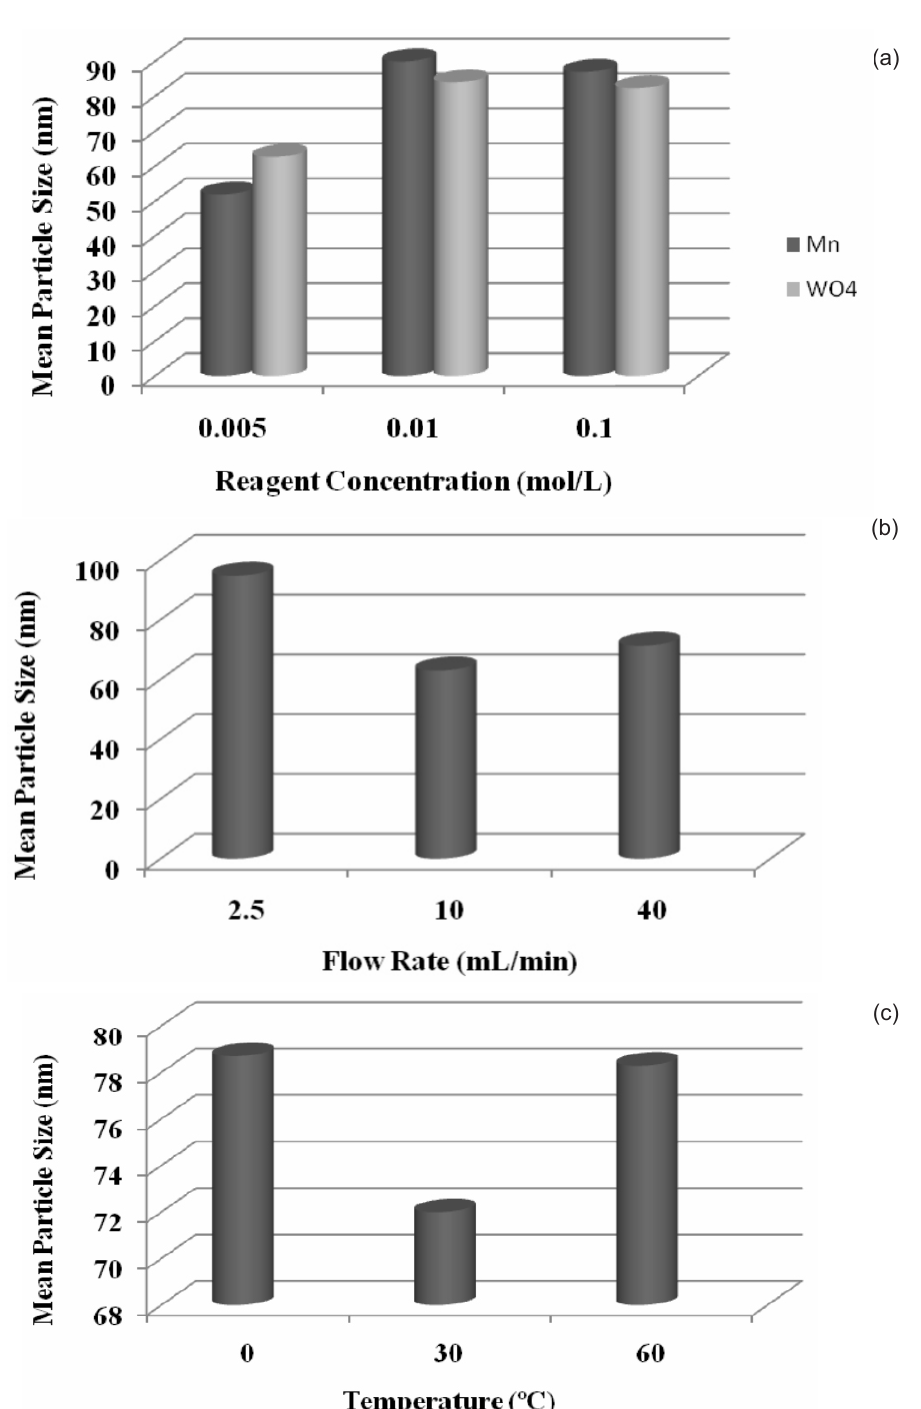
Figure 2. Average effect of each variable on the diameter of the MnWO